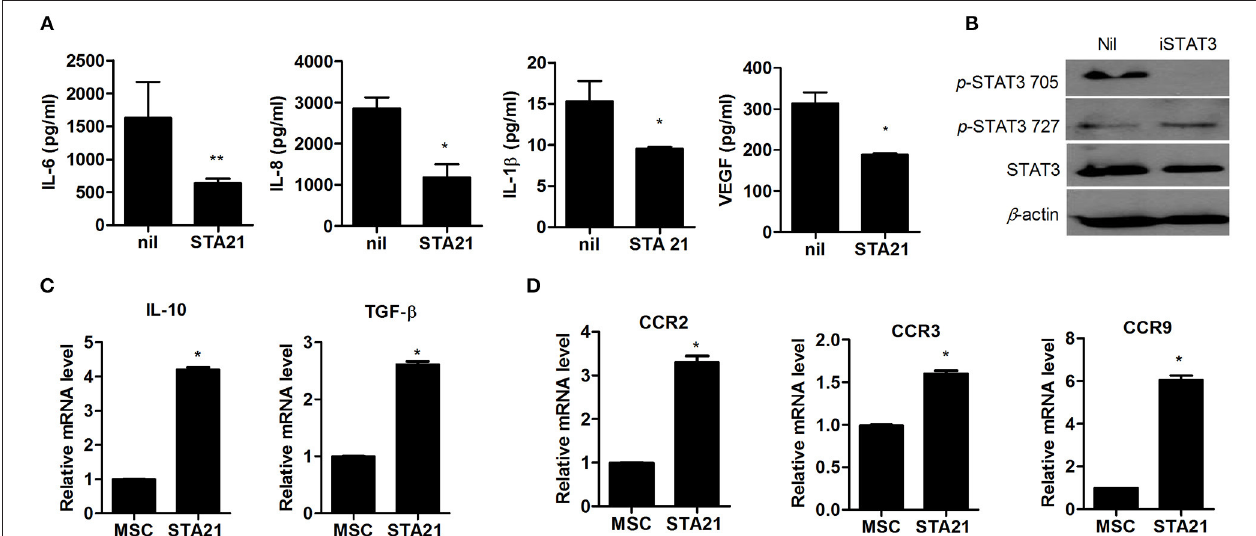
FIGURE 1 | Effects of STAT3 inhibition on anti-inflammatory activity and migration potential in MSCs from osteoarthritis (OA) patients. (A) OA-MSCs were incubated with STA21 for 3 days and, ELISA was performed to measure IL-6, IL-8, IL-1 β , and VEGF concentrations. (B) OA-MSCs were incubated with STA21 for 1h. The expression of phospho (p)-STAT3 705, 727, and total STAT3 protein was analyzed by Western blotting. (C) mRNA levels for anti-inflammatory cytokines IL-10 and TGF- β were measured by real time-PCR (D) Expression of chemokine receptors in OA-MSCs incubated with STA21 was measured by real time-PCR. OA-MSC were isolated of fat tissues obtain from each 3 person with OA. Data represent the mean ± SD of 3 independent experiments (* P < 0.05; ** p < 0.01).